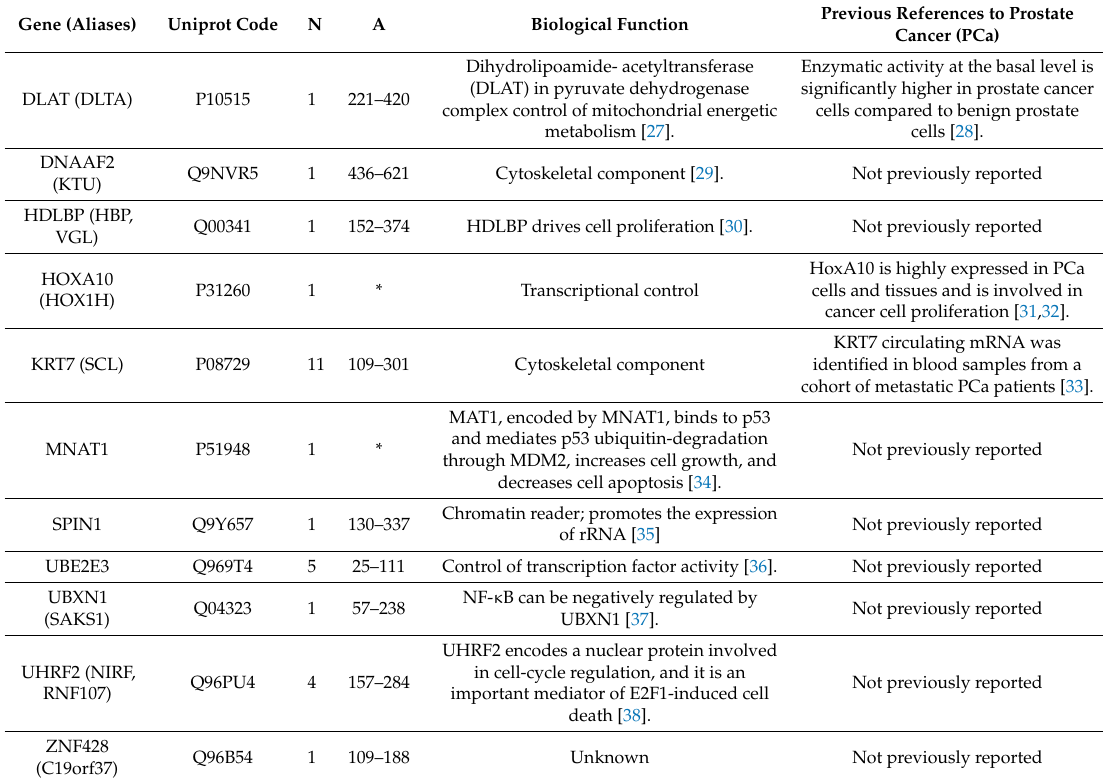
Table 1. Proteins identified in the high mobility group box B 1 (HMGB1) yeast 2-hybrid (Y2H) approach interactome in PC-3 cells.